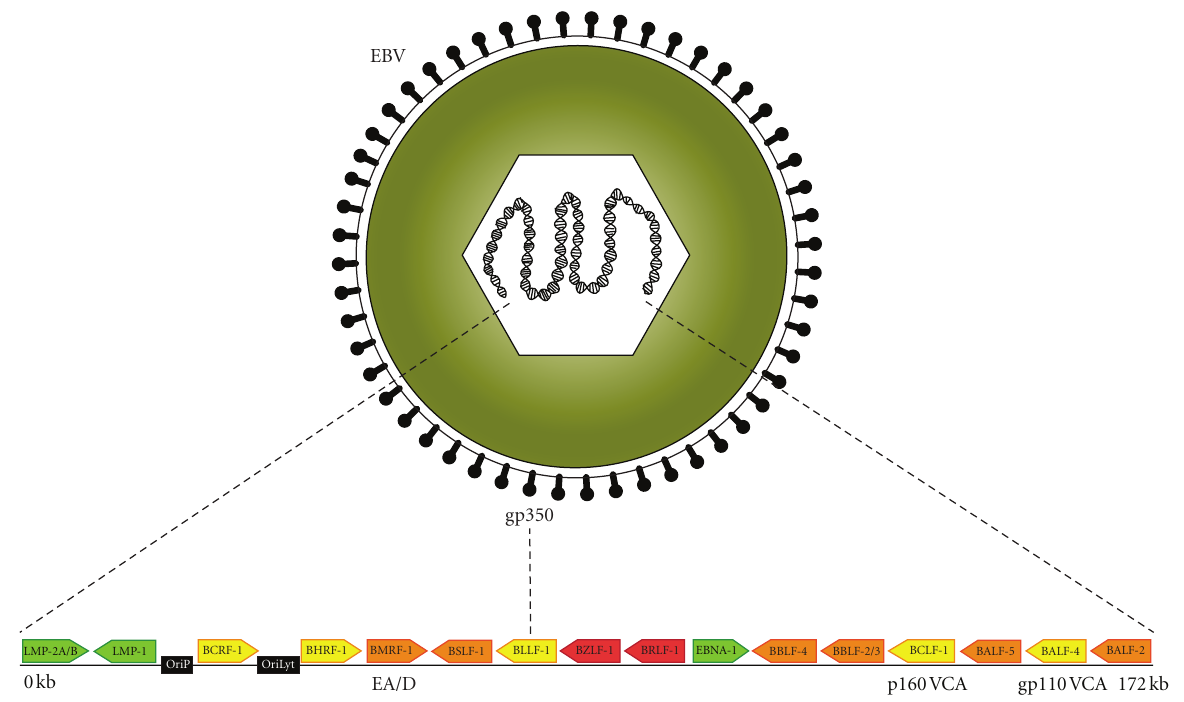
Figure 1: EBV structure and partial map of the genome. The EBV virion comprises a 172 kb linear dsDNA genome inside an icosahedral capsid enclosed by an envelope with viral glycoproteins (gp350) utilized for infection of B cells. The positions of the origins of latent and lytic replication of the viral genome, OriP and OriLyt, respectively, are illustrated in black boxes in the EBV genome map. Selected genes and their relative placement are shown as arrows pointed in the direction of translation [20]. In the latent state, only a few antigens are expressed including EBNA-1, LMP-1, and -2A/B (shown in green). Lytic replication begins with induction of the two early transcription factors (shown in red), which activate early viral promoters generating the initiation complex at OriLyt consisting of 6 viral gene products (illustrated in orange). During lytic cycle, various lytic antigens are expressed (shown in yellow) [20]. Gene products of BMRF -1, BCLF -1, and BALF -4 are depicted as EA/D, p160 VCA, and gp110 VCA,